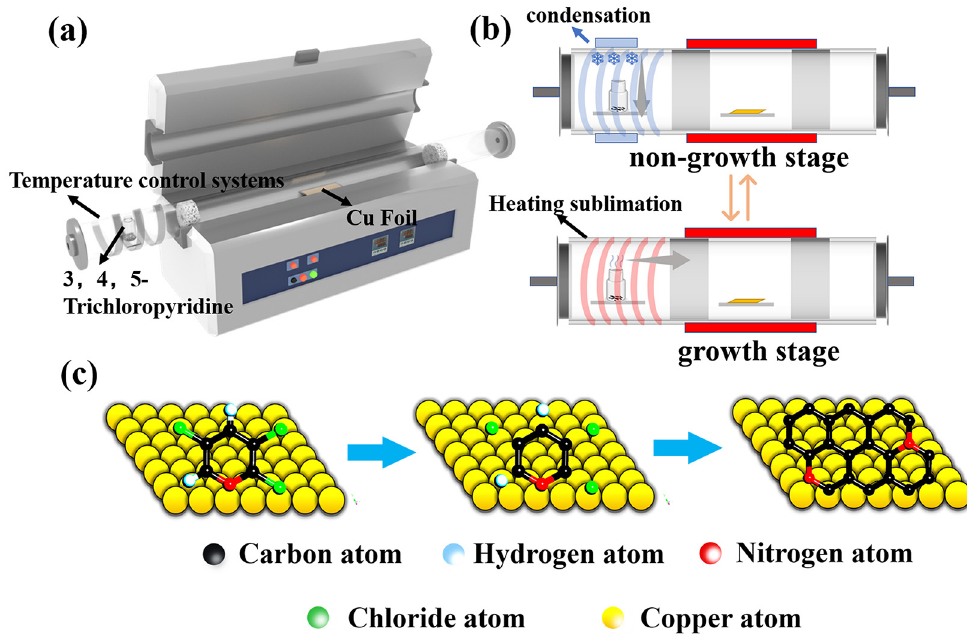
Figure 1. ( a ) Schematic diagram of preparing NG films on copper foil using 3,4,5-trichloropyridine as the source of carbon and nitrogen. ( b ) Diagram of the solid source region at different stages of synthesis in scheme II. ( c ) Growth of NG films on the copper foil via Ullmann radical coupling mechanism.